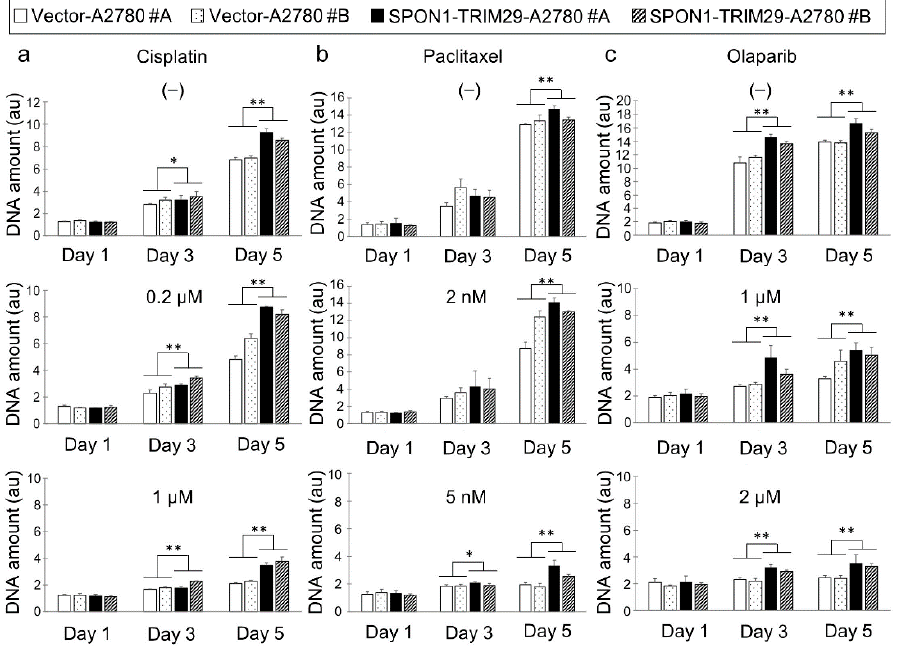
Figure 2. SPON1-TRIM29 expression blunts chemotherapy drug sensitivity in ovarian cancer